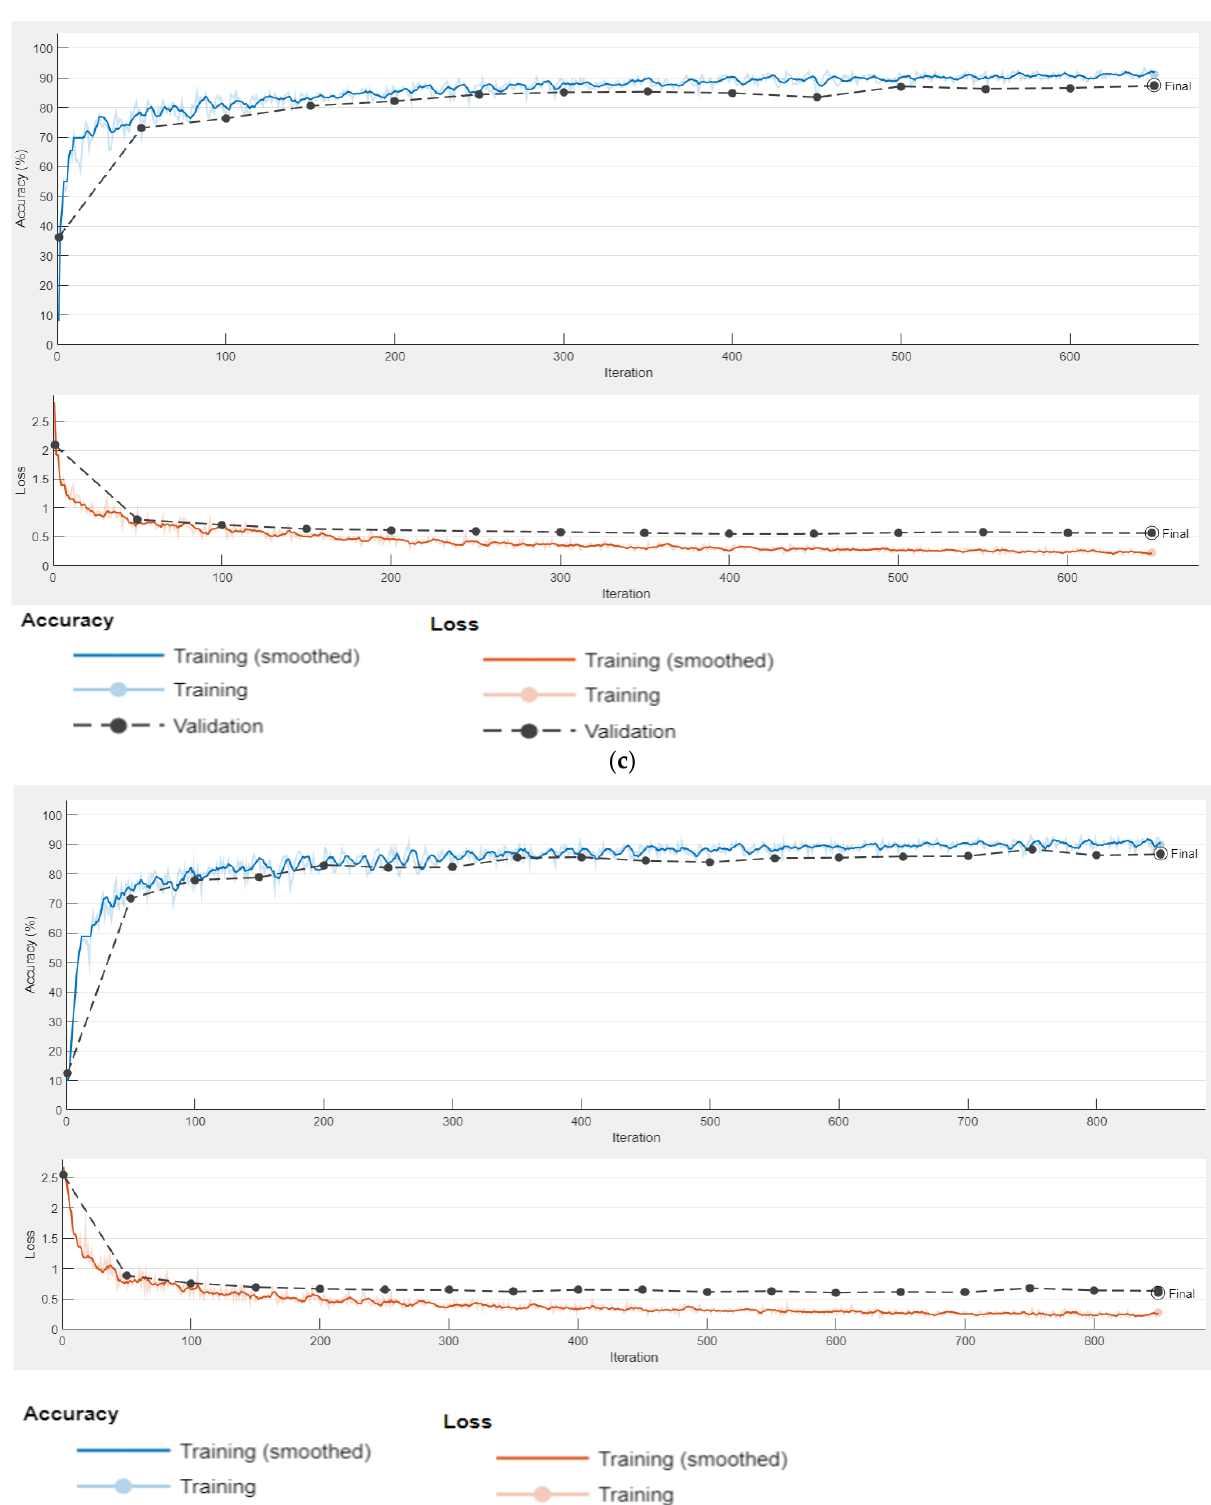
Figure 7. DCNN Accuracy and Loss Graphs. ( a ) ResNet-DeepLabV3+, ( b ) RGSNet-DeepLabV3+, ( c ) Customized Decoder-DeepLabV3+, ( d ) MobileNet-DeepLabV3+.